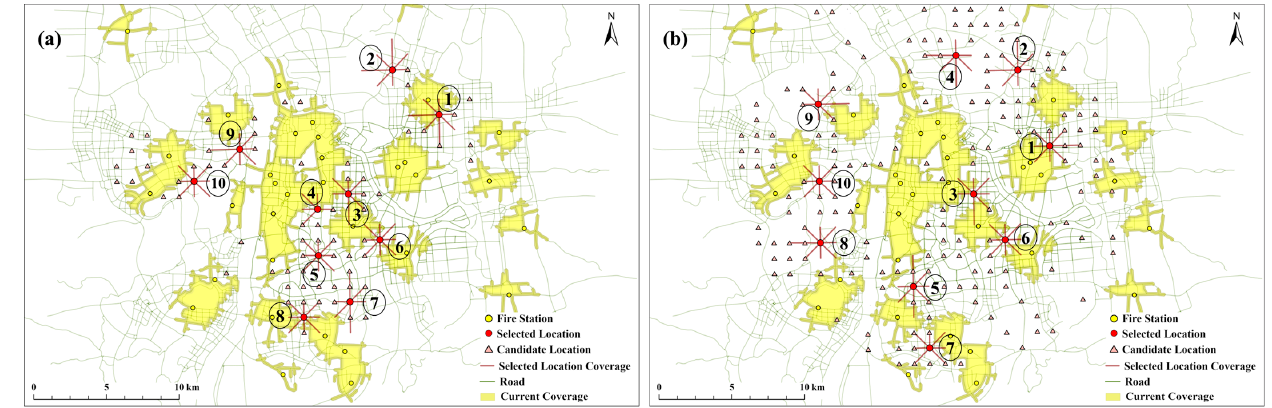
Figure 5. Map of potential fire station locations using ( a ) fire weighting data and ( b ) emergency service weighting